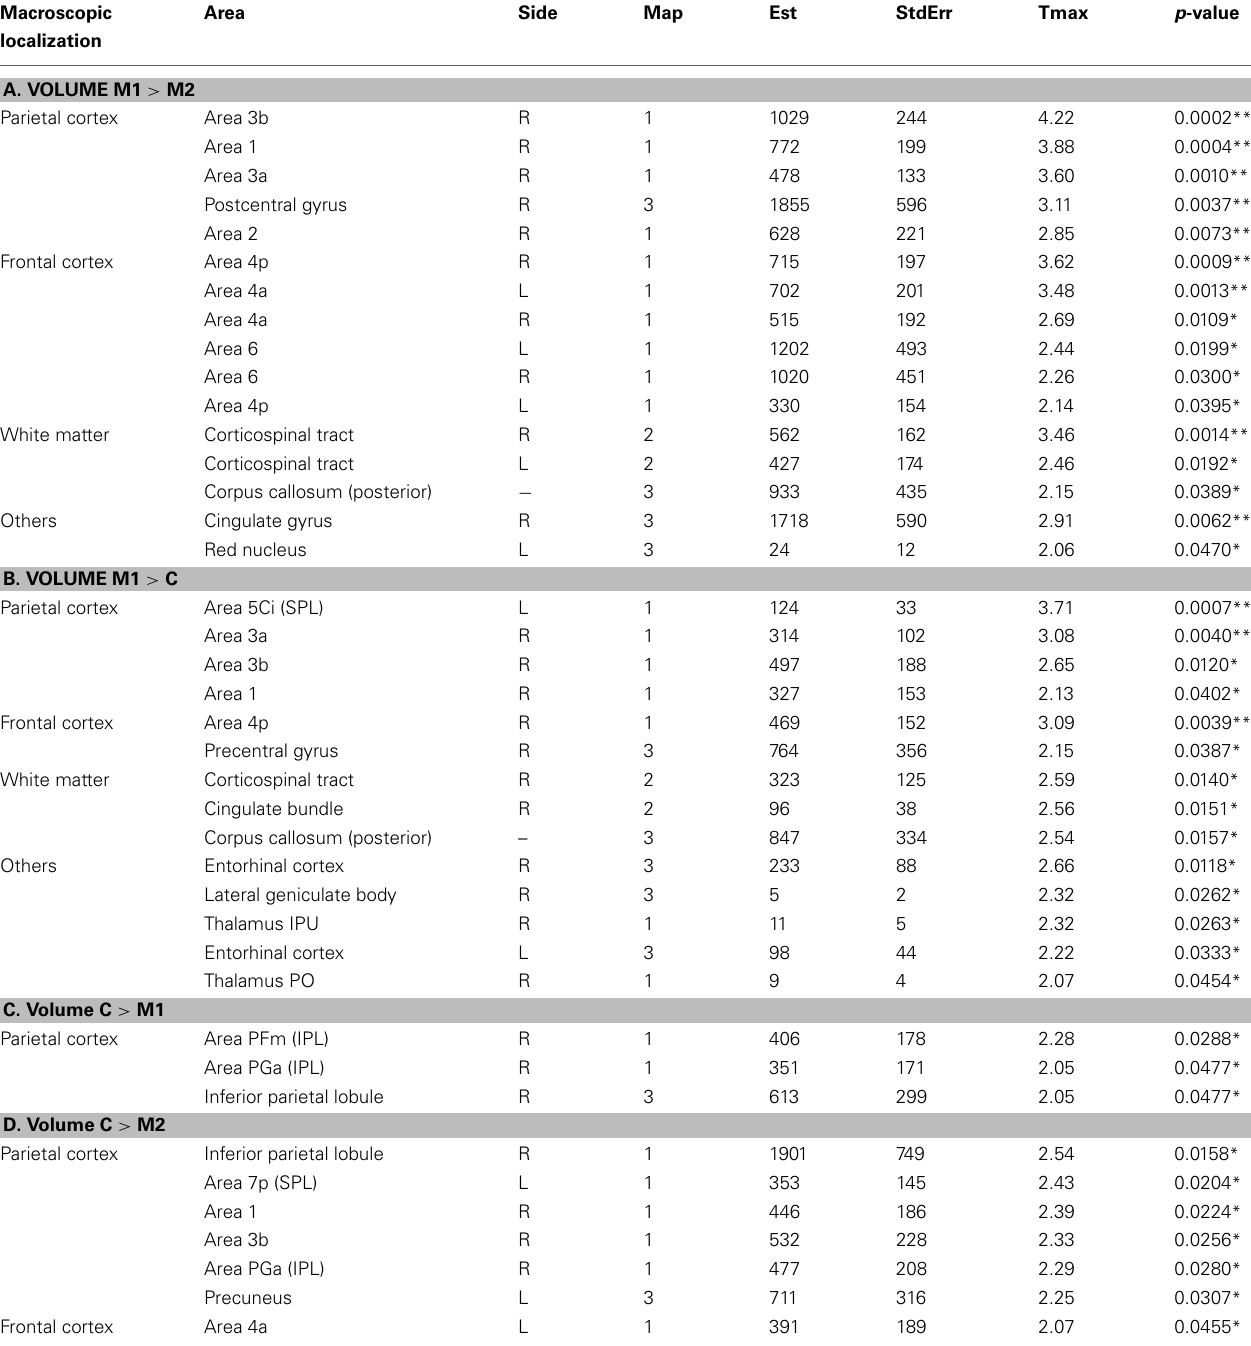
Table 3 | Volume difference between the groups from the ROI-analysis. Macroscopic Area Side Map Est StdErr